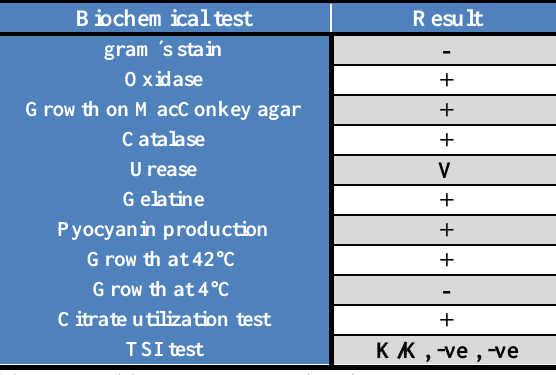
Table, 2: Biochemical test of P. aeruginosa